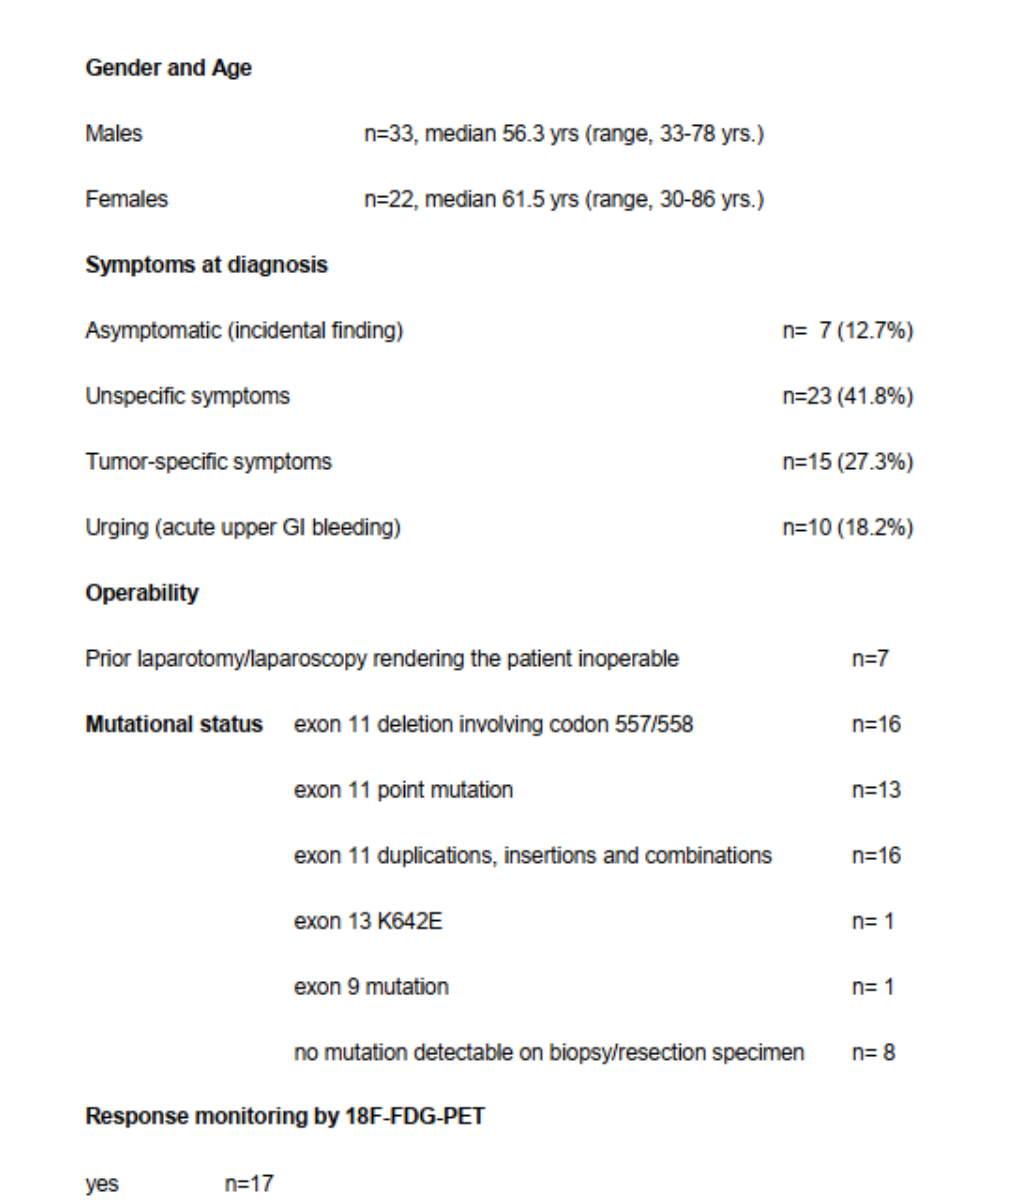
Figure 2. Demographic, clinical and histopathological data.